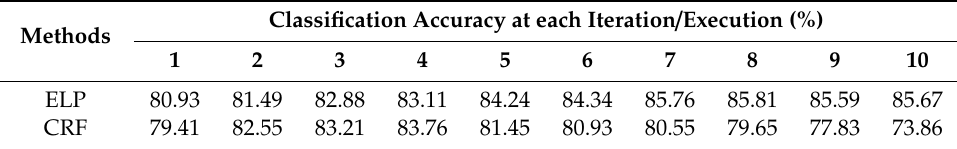
Table 3. Comparison of two algorithms by iteration/execution.